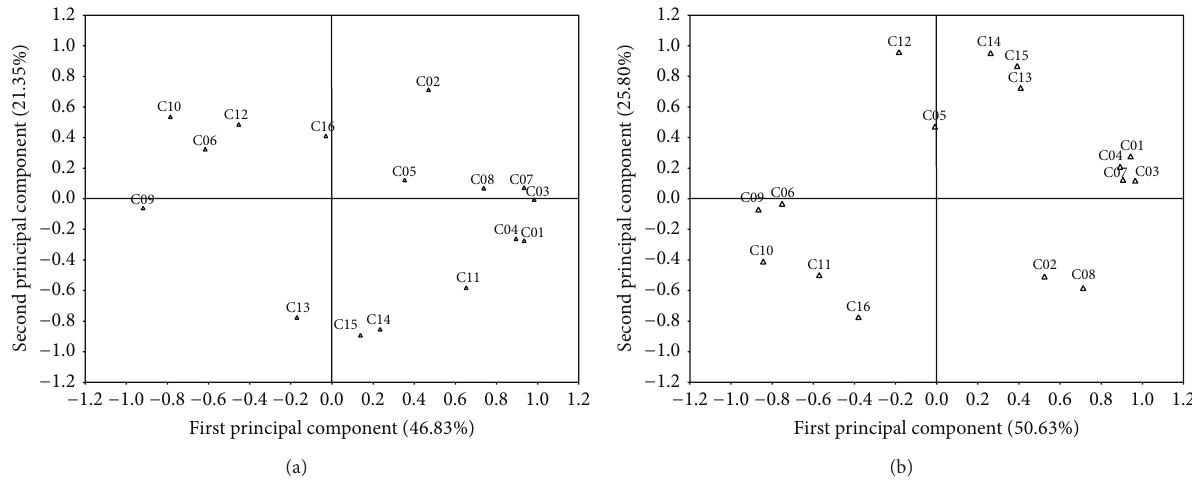
Figure 3: Distribution of the chemical constituents of the essential oil of L. gracilis in relation to the two principal components through analysis of the principal component analysis (PCA) for plants harvested in the rainy (a) and dry (b) seasons. (C01 = 𝛼 -thujene, C02 = myrcene, C03= 𝛼 -terpinene,C04=p-cymene,C05=limonene,C06=1,8-cineol,C07= 𝛾 -terpinene,C08=linalool,C09=methylthymol,C10=thymol, C11 = carvacrol, C12 = 𝛽 -caryophyllene, C13 = 𝛼 -humulene, C14 = bicyclogermacrene, C15 = spathulenol, and C16 = caryophyllene